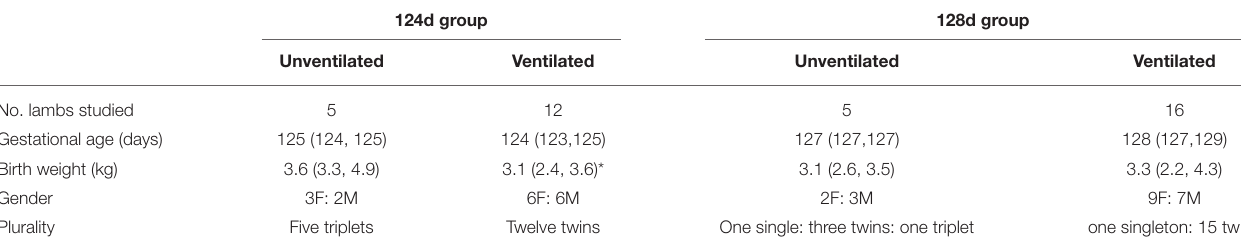
TABLE 1 | Birth characteristics of the Study 1 comparison